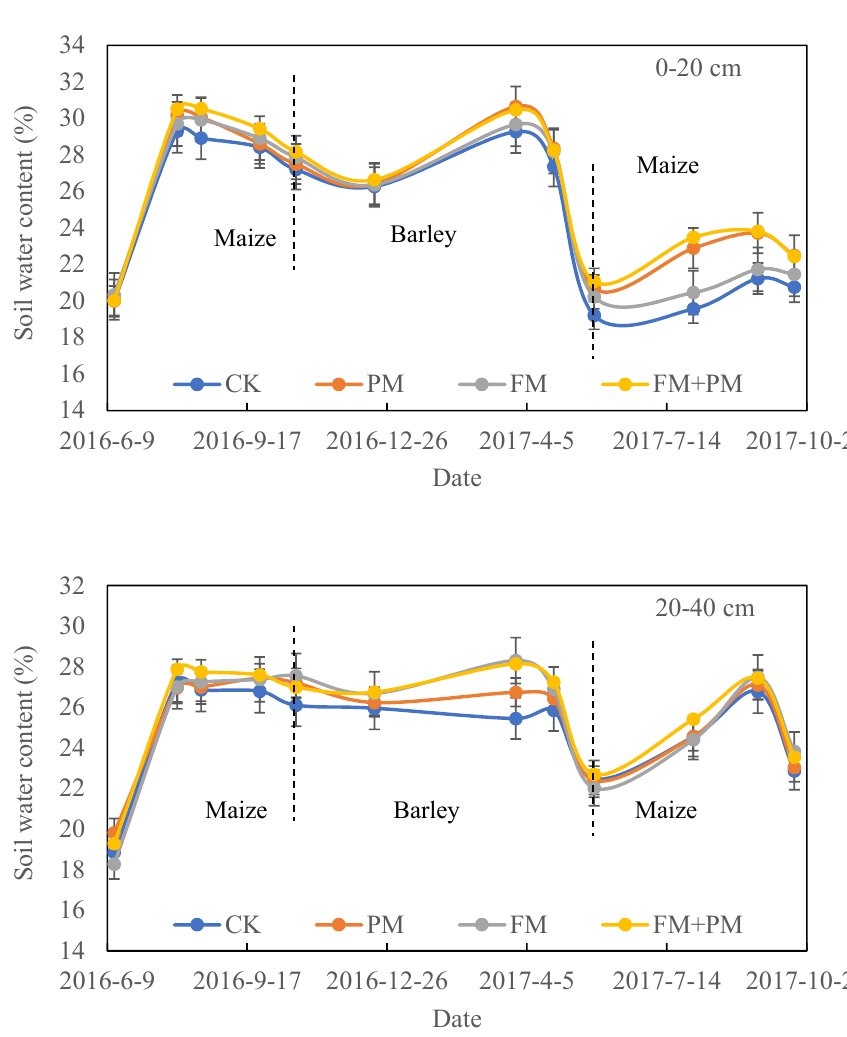
Figure 2. Soil water content in the 0–20 cm and 20–40 cm soil layers under CK, PM, FM, and PM+FM treatments during the experimental period. CK: control treatment, PM: plastic film mulch, FM: farmyard manure, PM+FM: plastic film mulch combined with farmyard manure. The vertical bars represent the standard deviations of the data.